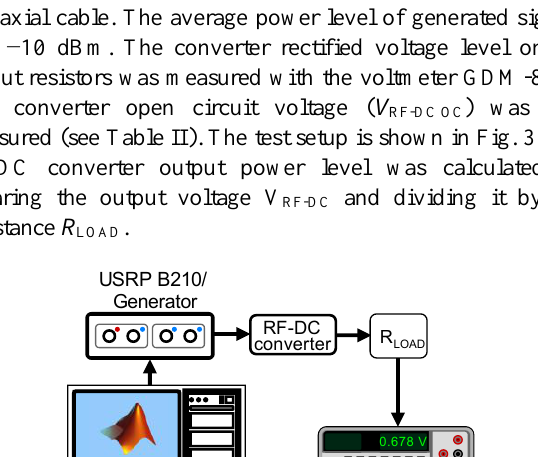
Fig. 2. Circuit of the employed low-power harvesting device with a DC-DC converter.